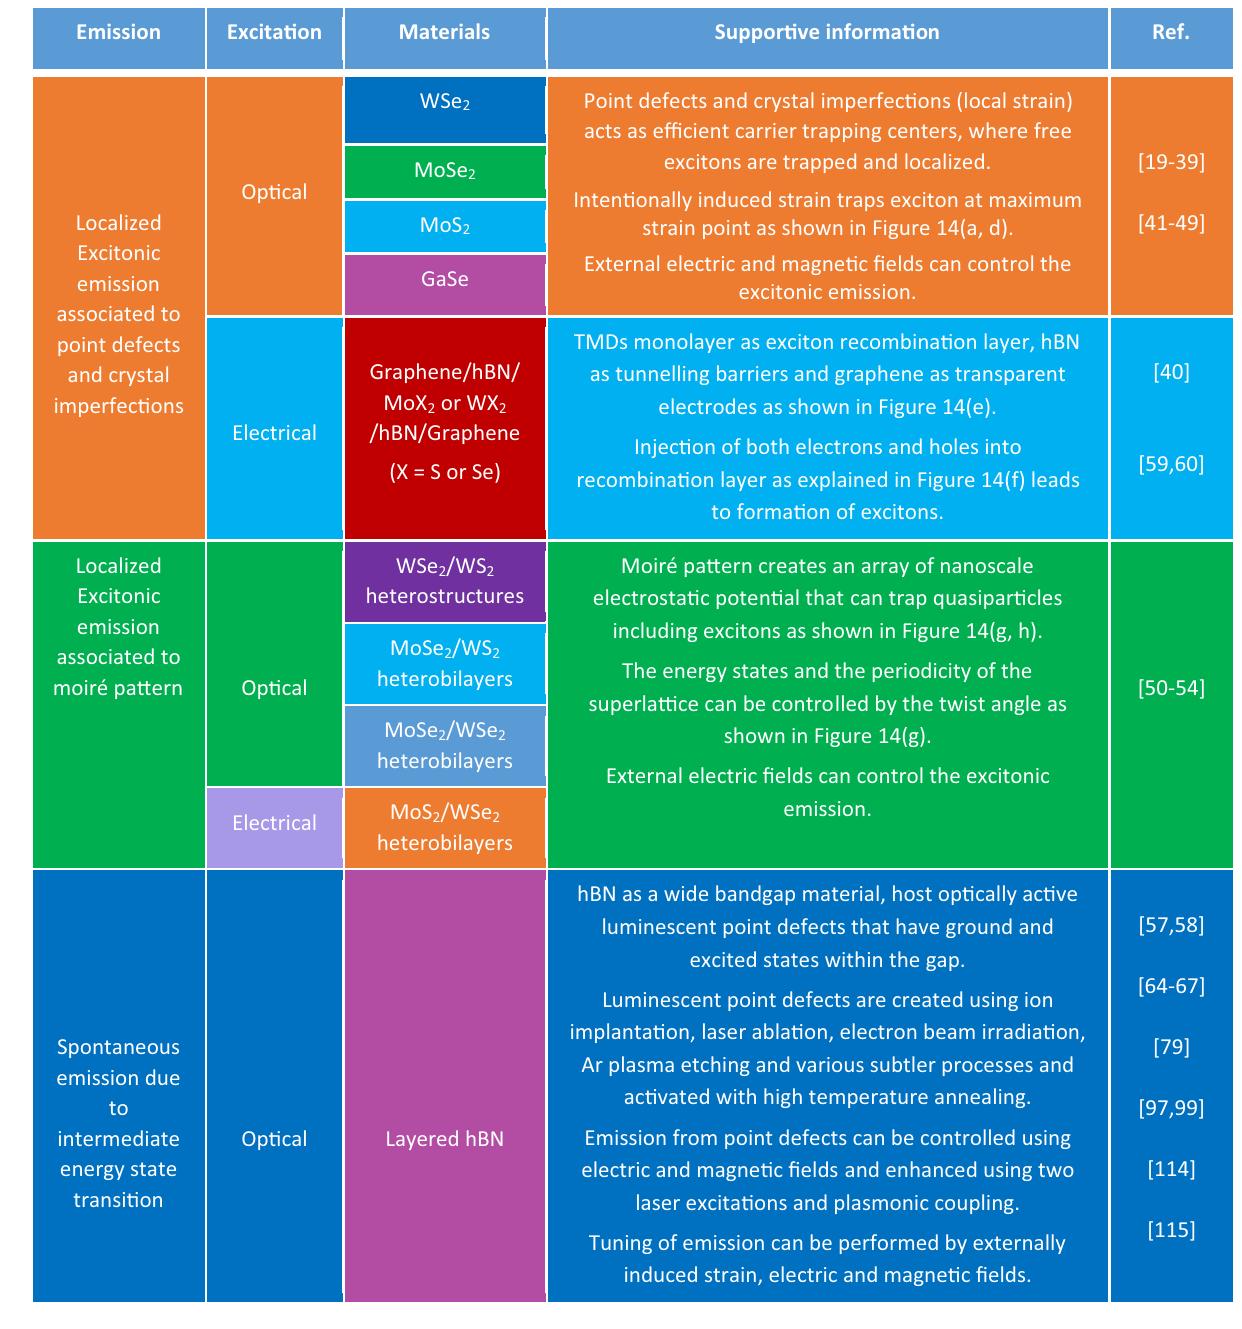
Table 16. Implementation of qubits using 2D materials. Qubits implementation using various 2D materials, bilayers and heterostructures, responsible excitation mechanisms and different emission phenomena and their corresponding detailed